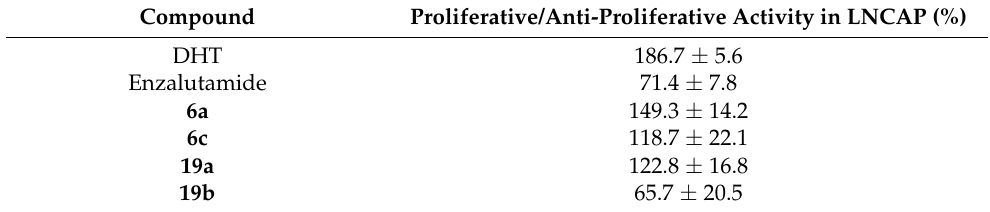
Table 4. Anti-proliferative activity of compounds 6a , 6c , 19a and 19b